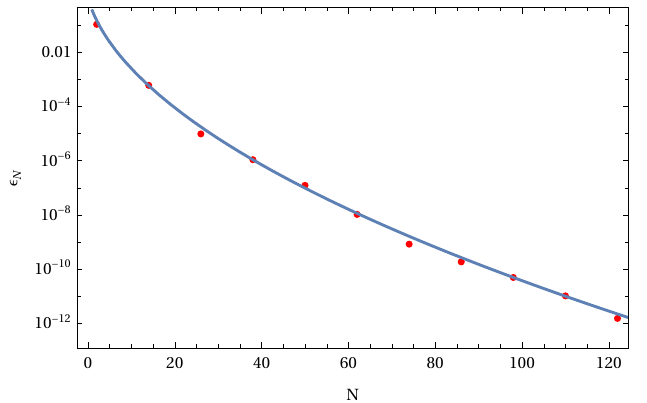
(cid:16) (cid:17) 1/2 − k for the Krätzel function with 2 N